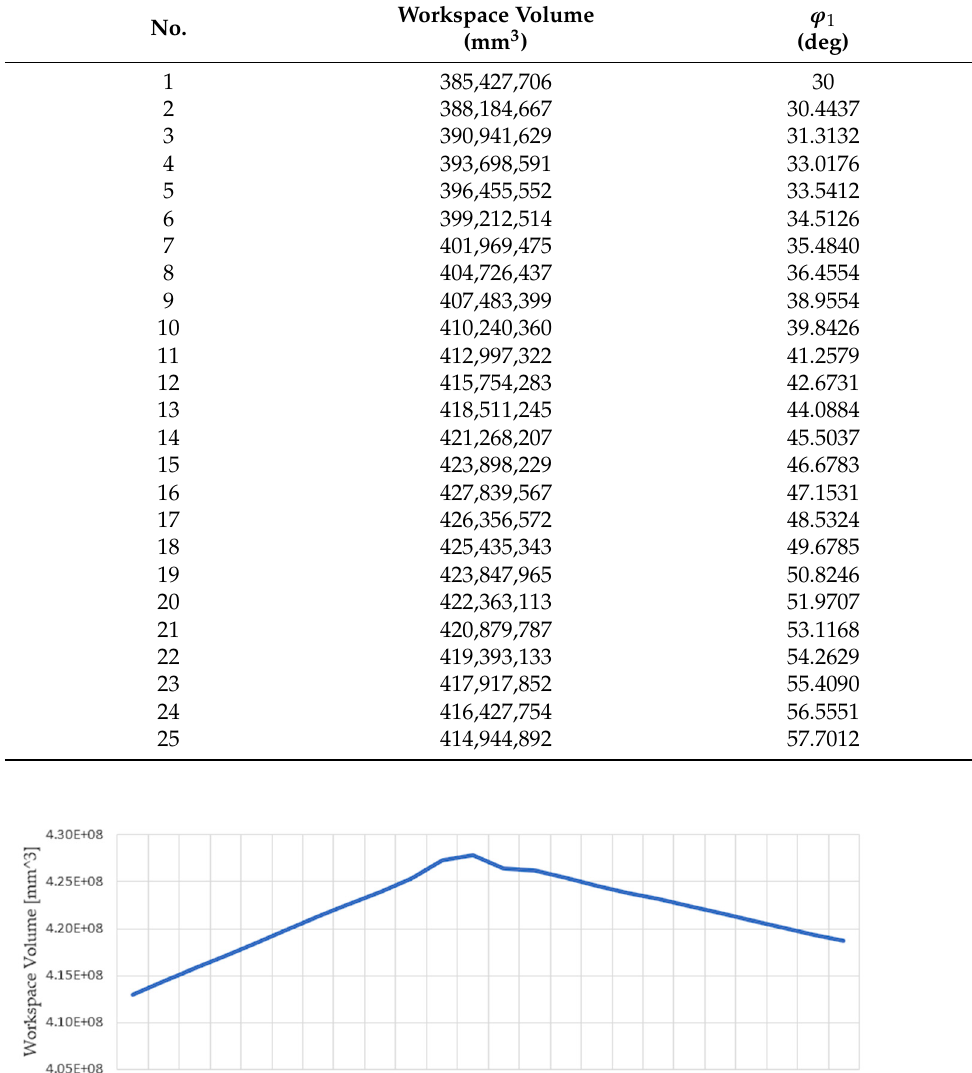
Table 2. Workspace volume (mm 3 ) results from product engineering optimizer module (CATIA V5).